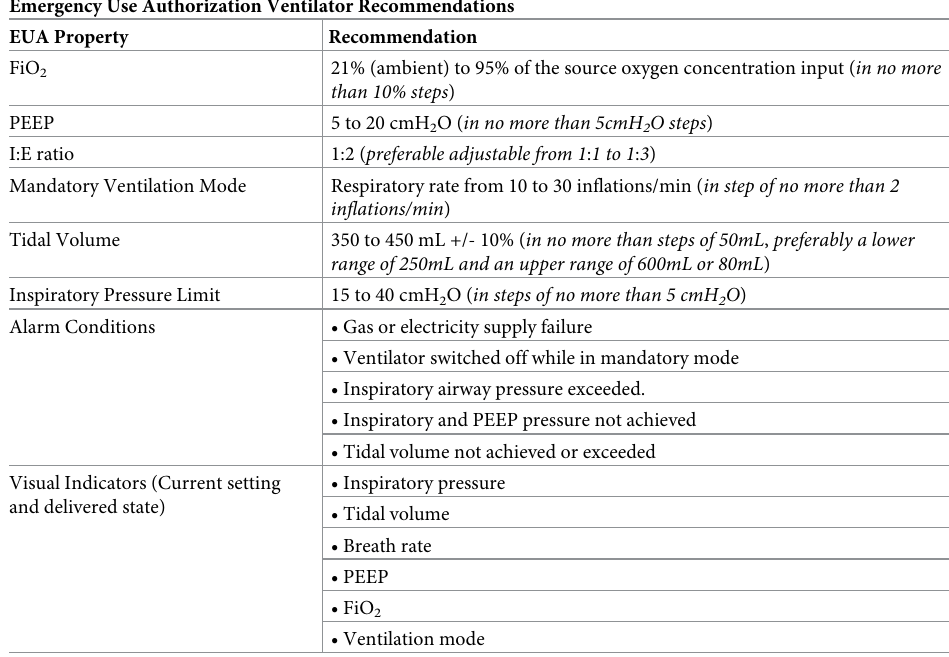
Table 1. Emergency use ventilator minimum requirements for treating COVID-19 patients according to (AAMI,